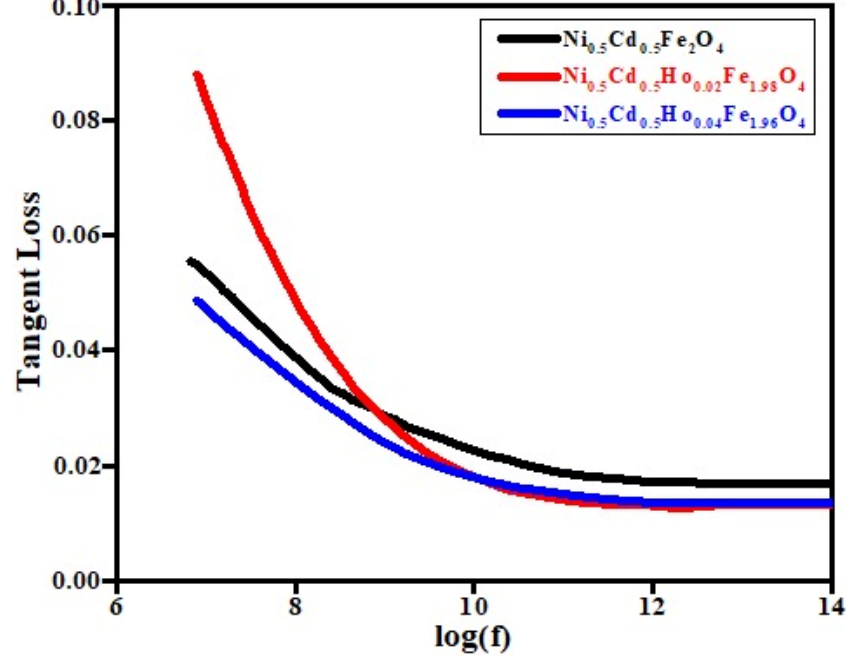
Figure 5. Tangent loss vs. log(f) plot for Ni 0.5 Cd 0.5 Ho x Fe 2-x O 4 (x = 0, 0.02, and 0.04).